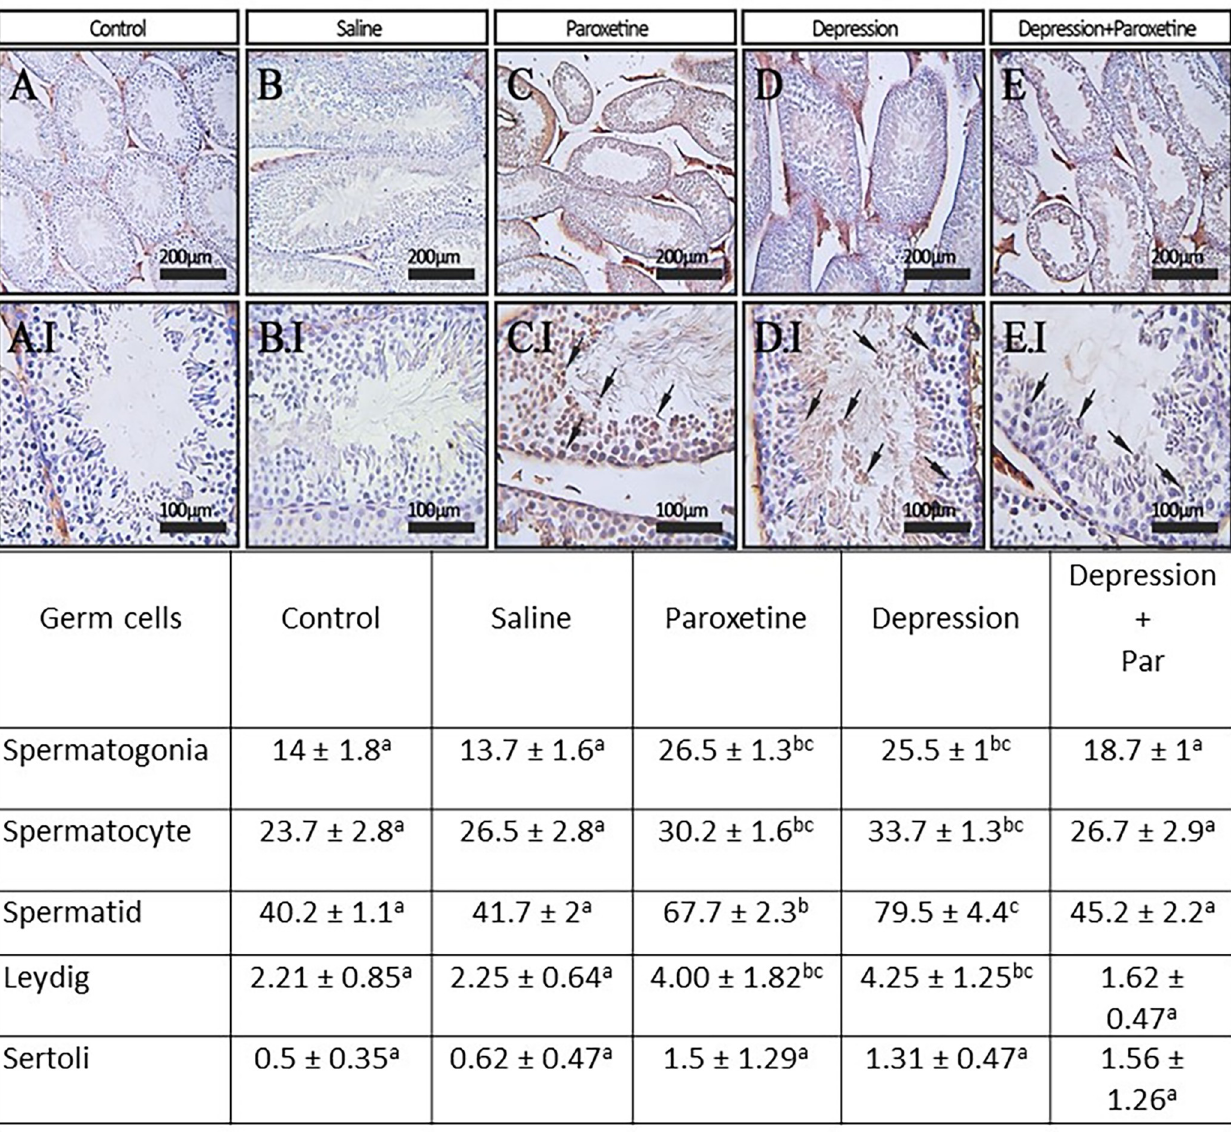
Fig 3. Immunohistochemical staining of CASPASE-3 in testes cross-sections. Comparison of mean percentage of Caspase-3 -positive cells in germ cells (spermatogonia, spermatocytes, spermatids, Leydig, and Sertoli cells) within groups. The values with different superscript letters in each row are significantly different (p �